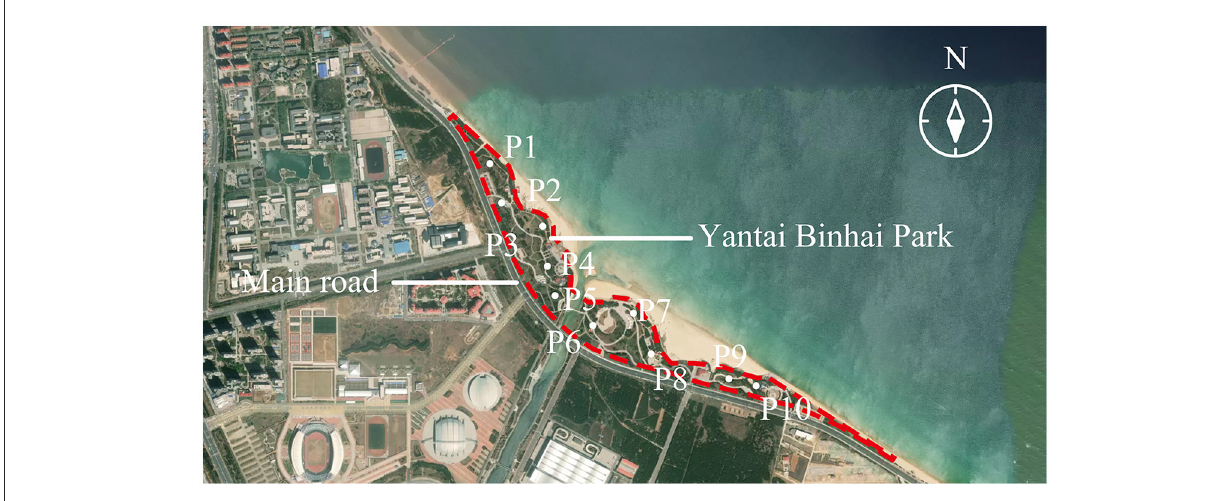
FIGURE1 Filtered 10 survey positions in the Yantai Binhai Park (YBP).